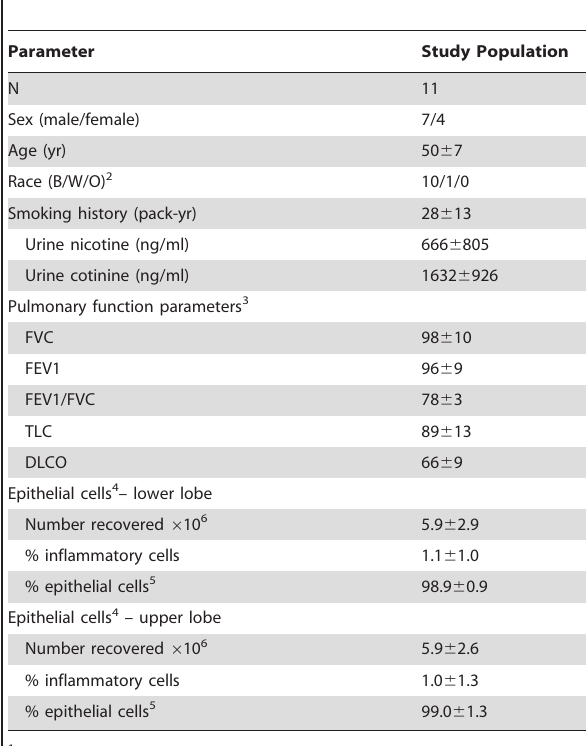
Table 1. Demographics of the Study Population and Airway Epithelial Samples.